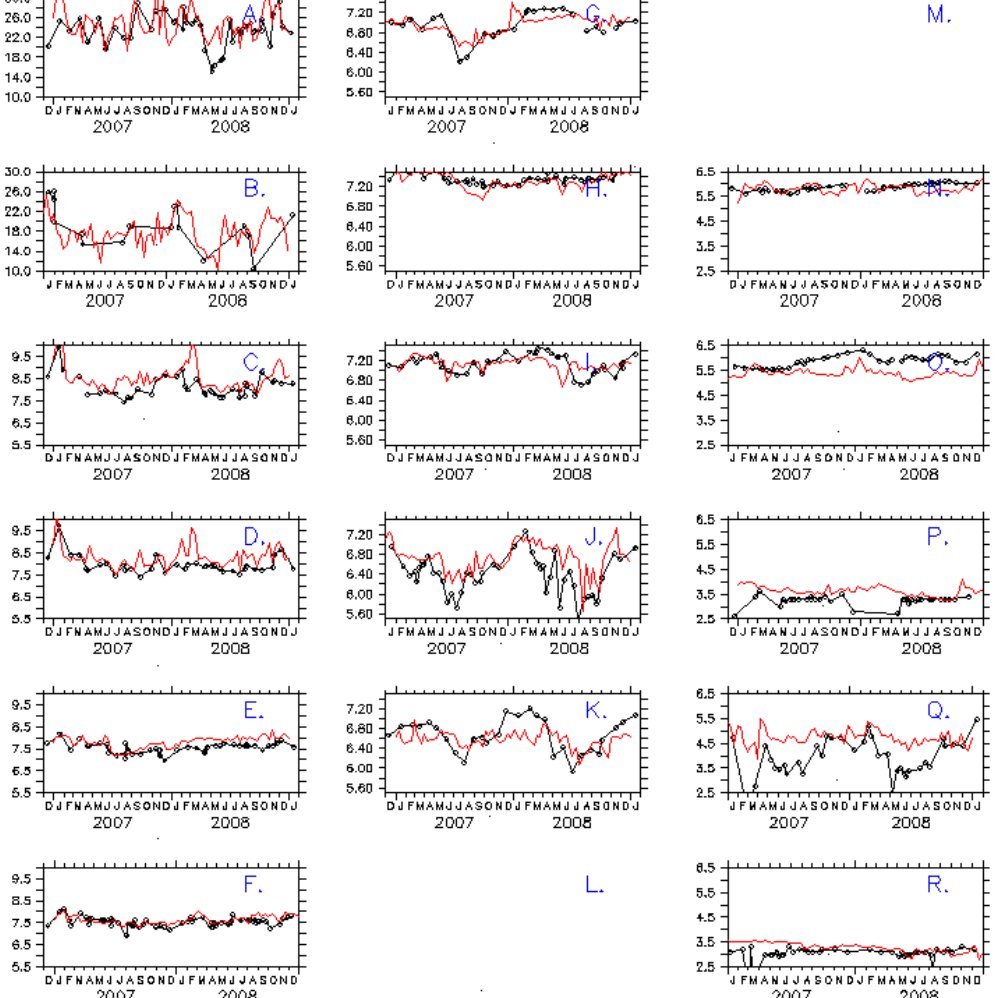
Fig. 4. Seasonal variability of salinity in surface layer. Red solid curve (black dashed cycles) for model results (observations). Unit: PSU. Panels (A–R) for Stations A–R (Fig. 1),